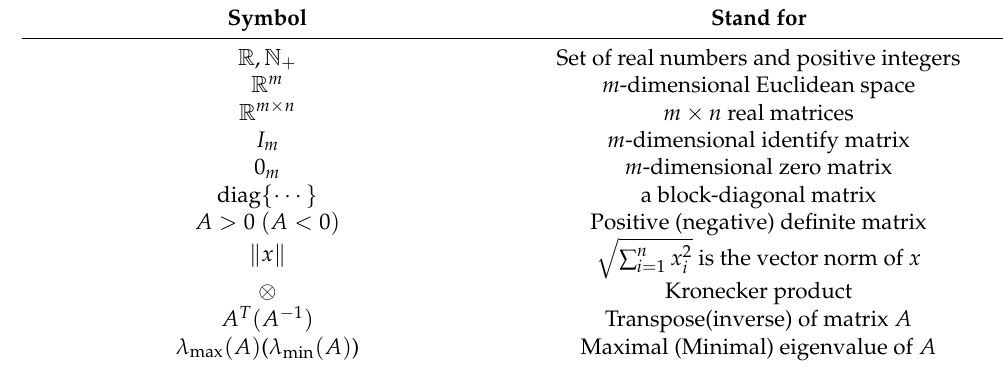
Table 1. Notations. Symbol Stand for R , N + Set of real numbers and positive integers R